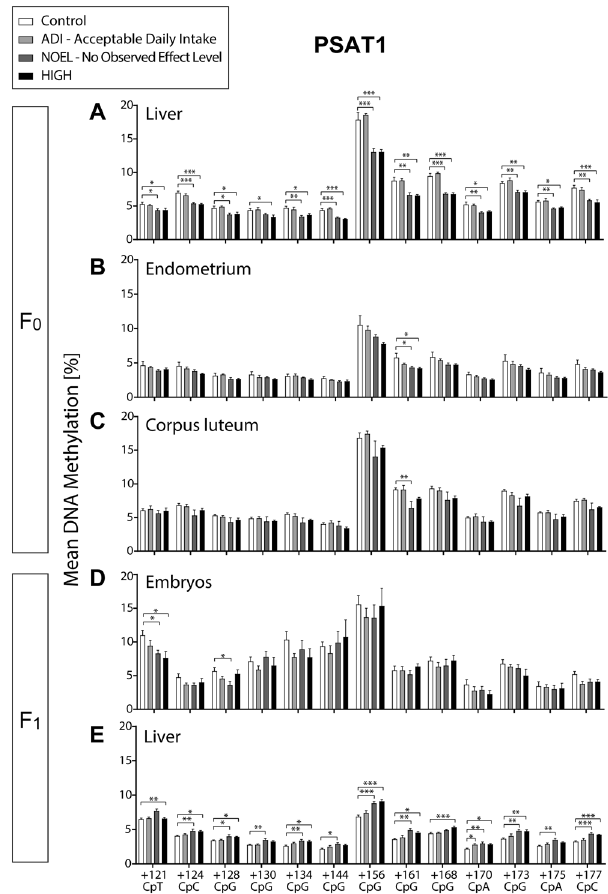
Figure 5. E2 induced consistent DNA hypomethylation in the PSAT1 coding region (first exon) in F 0 liver, endometrium, and corpus luteum, and F 1 embryos but hypermethylation in corresponding CpG sites of the liver of adult F 1 animals. Bar charts represent mean ± SEM of % DNA methylation per group in different shades of grey (0.05, 10, and 1000 μ g/kg body weight/day represented by ADI, NOEL, and HIGH dose, respectively). * , ** , and *** indicate statistical significance with respect to the control group at p < 0.05, p < 0.01, and p < 0.001, respectively (n = 4–6 per group for tissue samples, and n = 8–10 for embryos). ( A ) F 0 liver DNA hypomethylation at all analysed CpN sites. ( B ) F 0 endometrium DNA hypomethylation at CpN + 161. ( C ) F 0 corpus luteum DNA hypomethylation at CpG + 161. ( D ) F 1 embryo DNA hypomethylation at CpN + 121, and + 128 ( E ) F 1 liver DNA hypermethylation at all analysed CpN